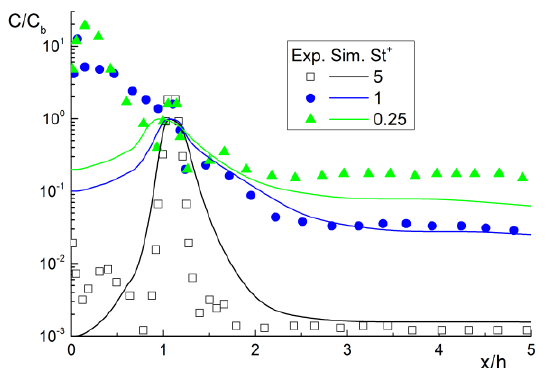
Figure 13. Concentration profiles of the dispersed phase at y = 0.02 h vs. the Stokes number St + along the length of the channel behind a 2D obstacle. The points are LES calculations [10]; the lines are the authors’ predictions. h = H /7, V P 1 = U m1 /25, Re = HU m1 / ν = 740, ρ P / ρ = 769.2. Reprinted with permission from (Grigoriadis, D.G.E. et al.)